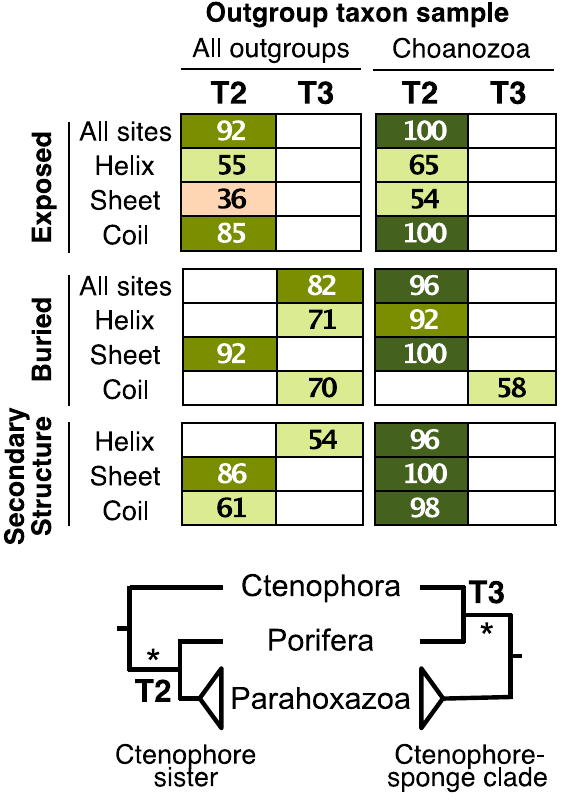
Figure 3. Heat map showing support for tree topologies obtained using various structural classes and taxon samples. In the online version colors indicate bootstrap support values (Dark green > 95, Lighter green > 75, Yellow > 50 and Pink < 50; No color: Topology was not recovered).